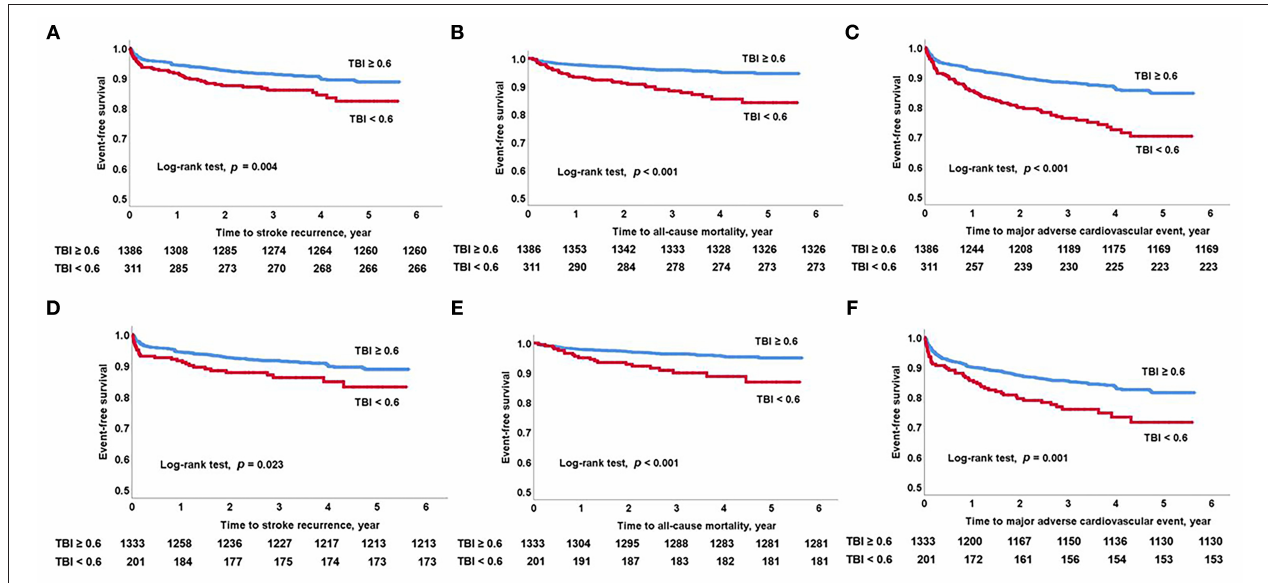
FIGURE 2 | Kaplan–Meier survival analysis. Long-term outcomes as predicted by low TBI. (A) Stroke recurrence, (B) all-cause mortality, and (C) major adverse cardiovascular event in all study patients. (D) Stroke recurrence, (E) all-cause mortality, and (F) major adverse cardiovascular events in patients with normal ABI. ABI, ankle-brachial index; TBI, toe-brachial index.